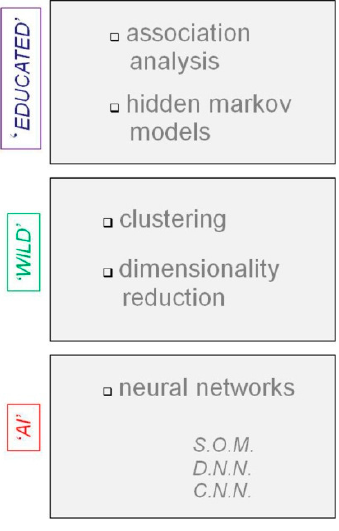
Figure 2. Analytic approaches to big data : From unsupervised machine learning (‘educated’ or ‘wild’) to artificial intelligence (AI).